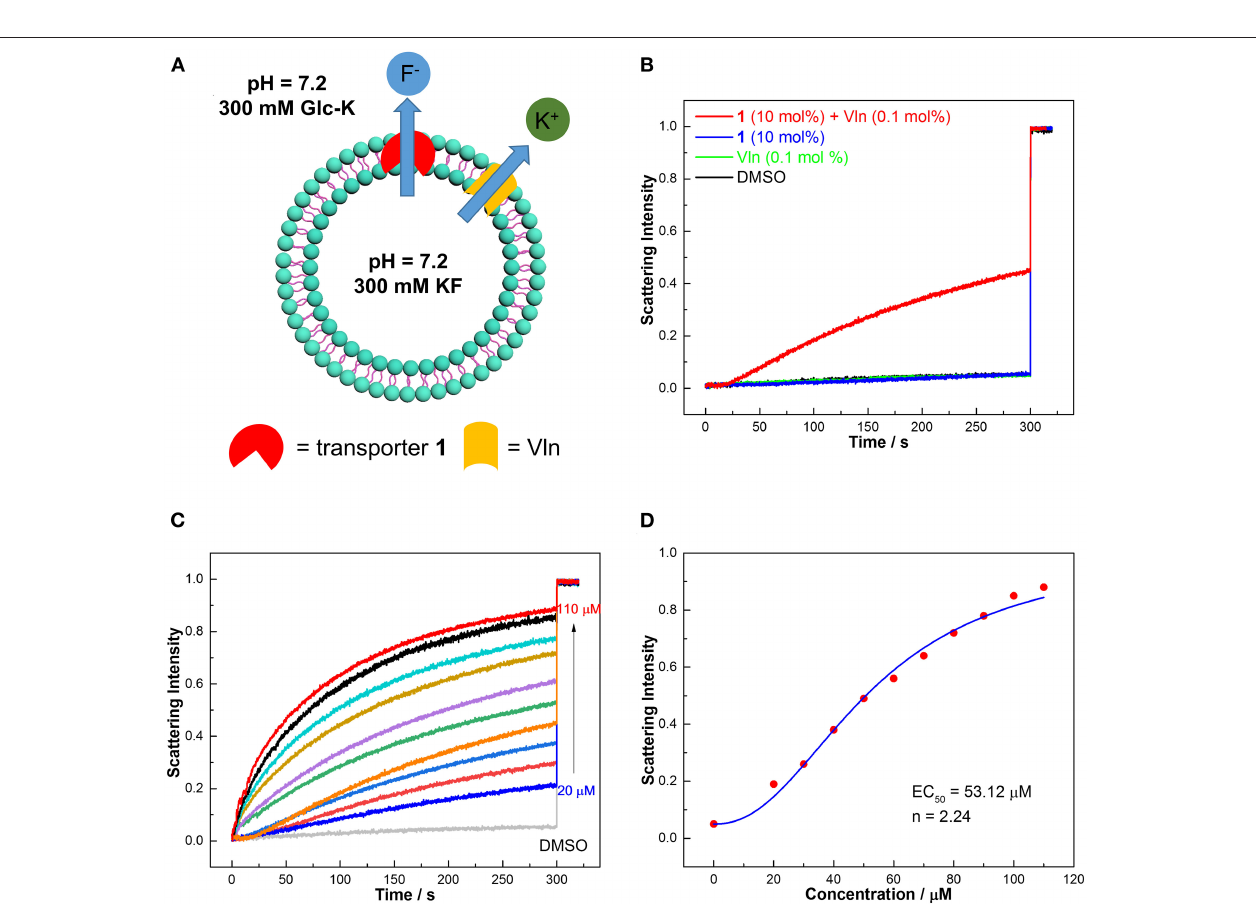
the presence of Vln, the KF efflux could reach 47% in